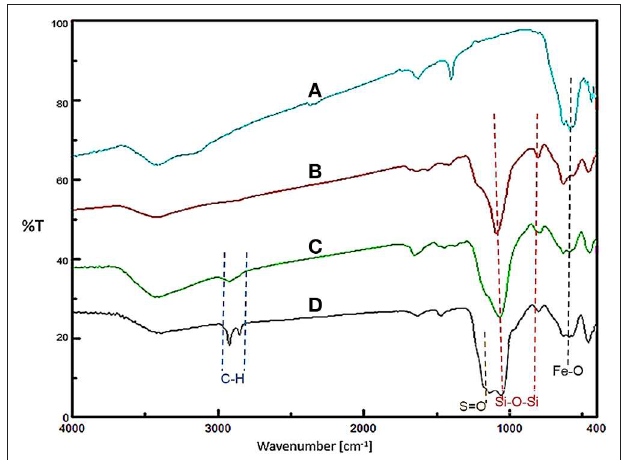
FIGURE 1 | FT-IR spectra of (A) Fe 3 O 4 , (B) Fe 3 O 4 @SiO 2 , (C) Fe 3 O 4 @OS, and (D) Fe 3 O 4 @OS-SO 3 H nanomaterials. FIGURE 2 | FT-IR spectra of (A) Fe